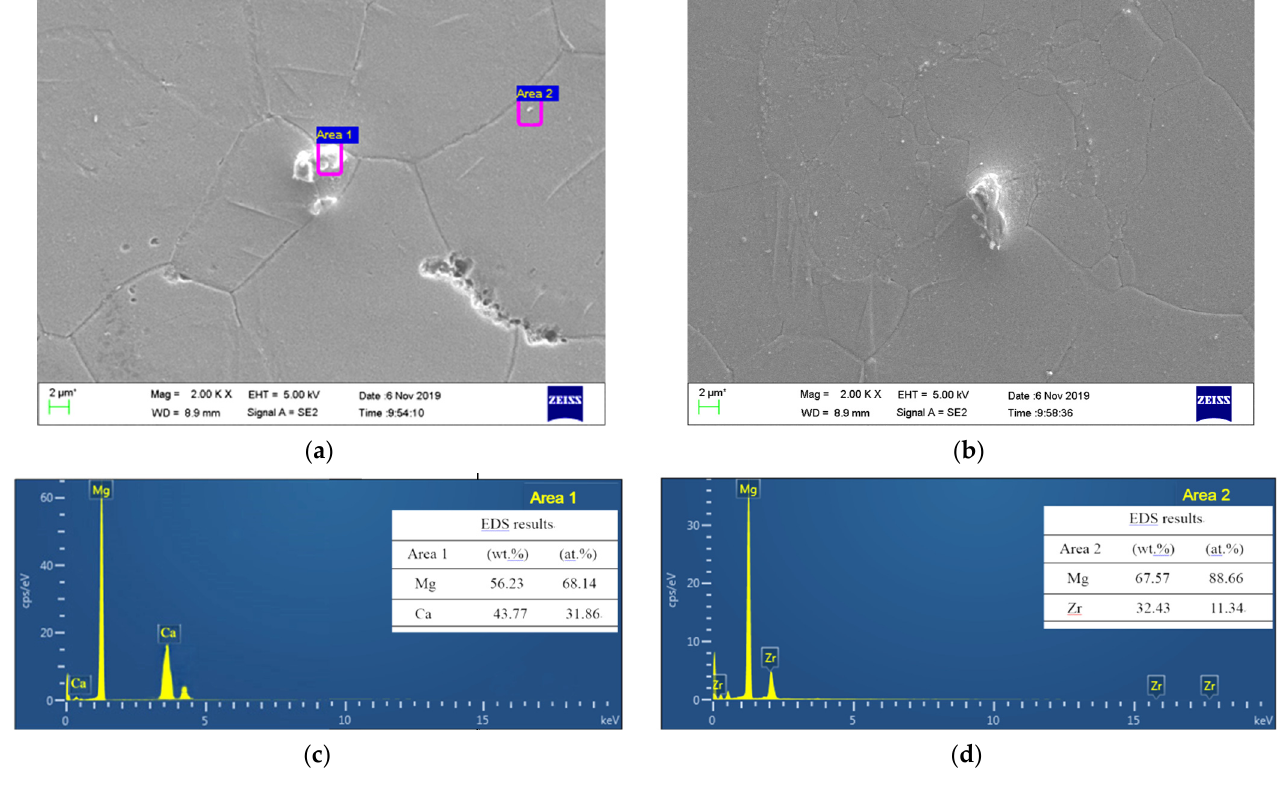
Figure 6. SEM microstructure of ( a ) as-extruded Mg-0.5Ca-0.5Zr alloy and ( b ) as-extruded Mg-0.5Ca-1Zr alloy. ( c ) EDS analysis of area 1 and ( d ) EDS analysis of area 2.